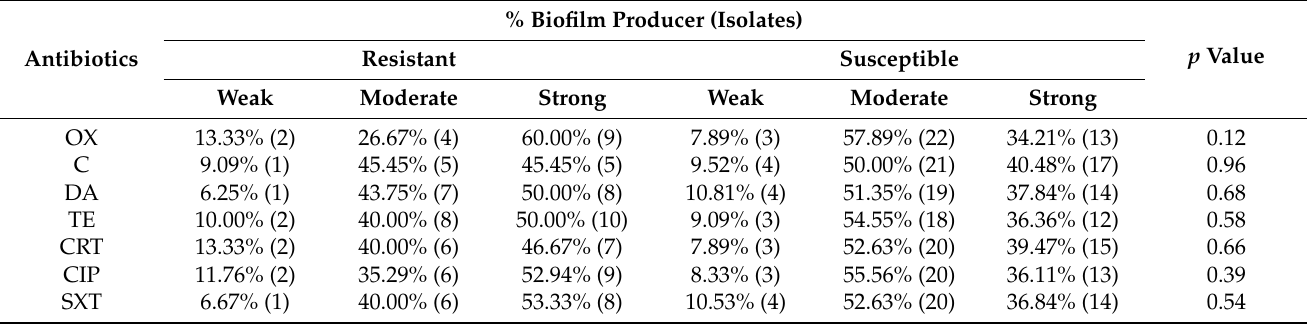
Table 3. Correlation between antibiotic resistant/susceptible strains and biofilm formation ability by the phenotypic method.